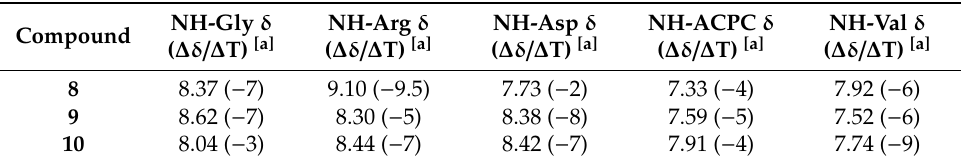
Table 3. Chemical shifts ( δ , ppm) and temperature coe ffi cients ( ∆ δ / ∆ T, ppb K − 1 ) of amide protons of peptidomimetics 8 – 10 in H 2 O solution.